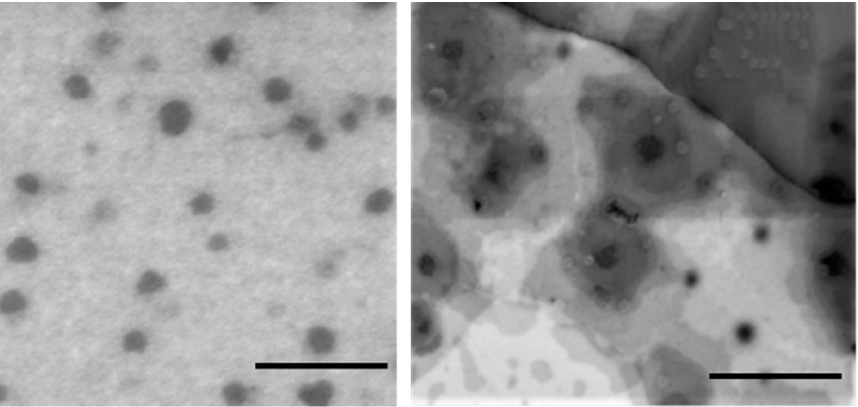
Figure 2. ME-1-OA ( left ) and ME-2-OA ( right ) TEM analysis. Bar: 500 nm.